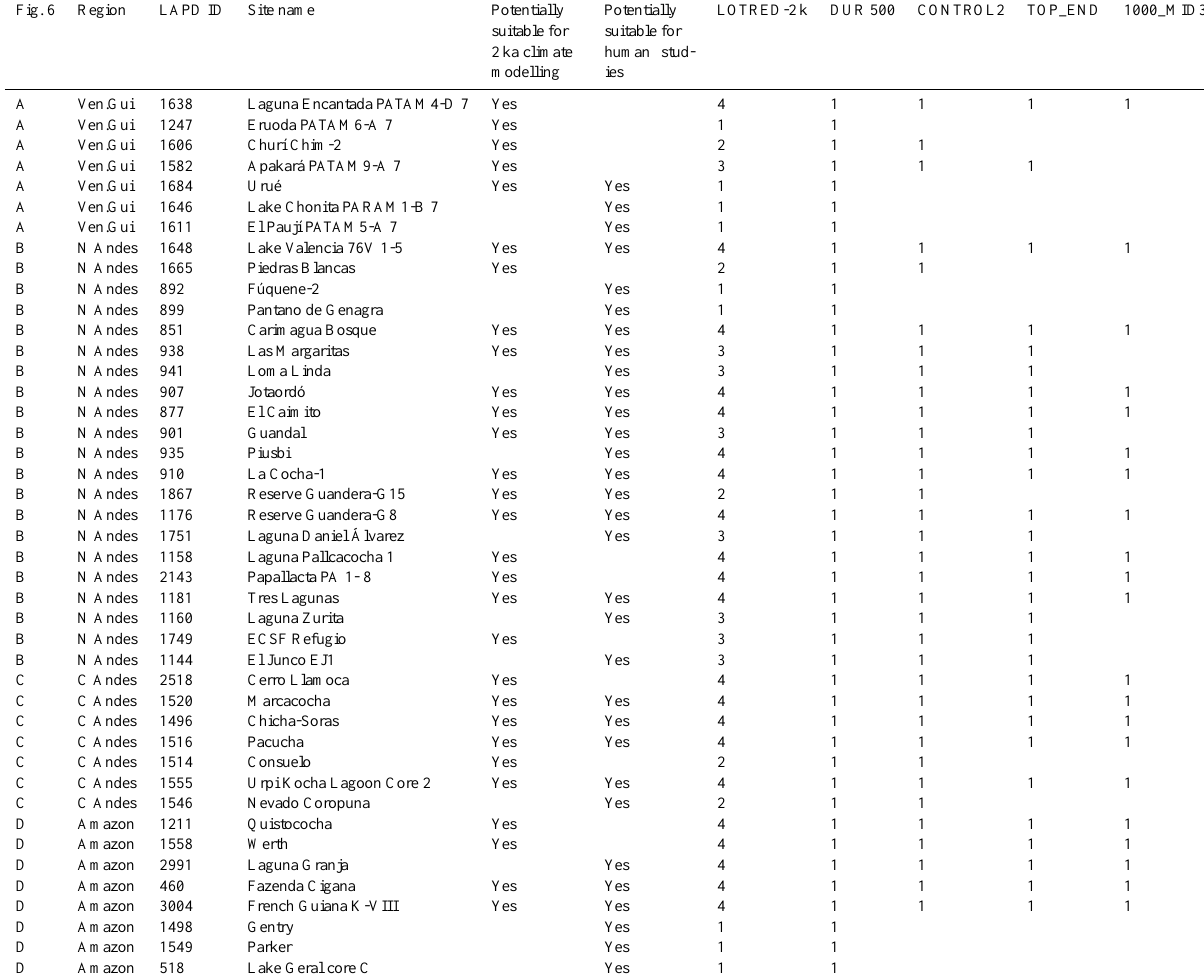
Table 3. List of pollen records used and metadata. Fig. 6